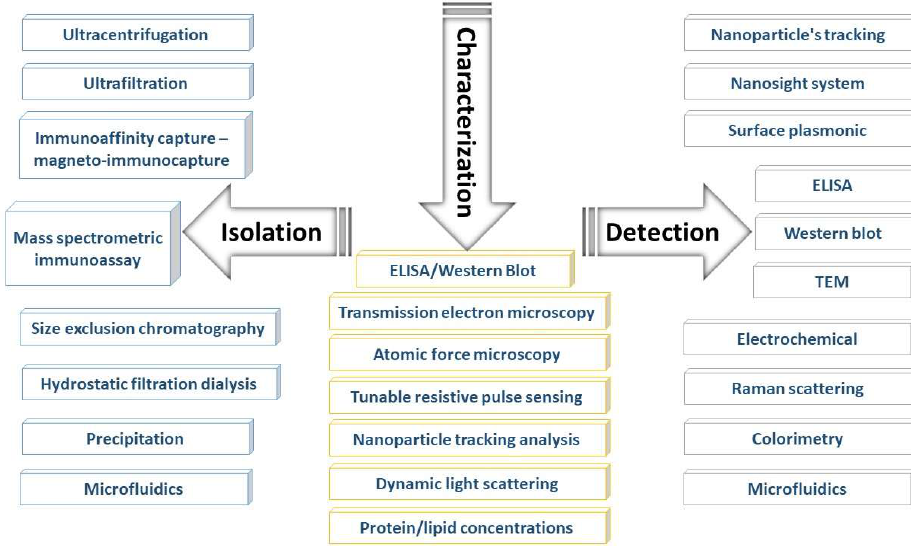
Figure 3. Isolation and characterization techniques for exosomes. Table 1. Isolation techniques for